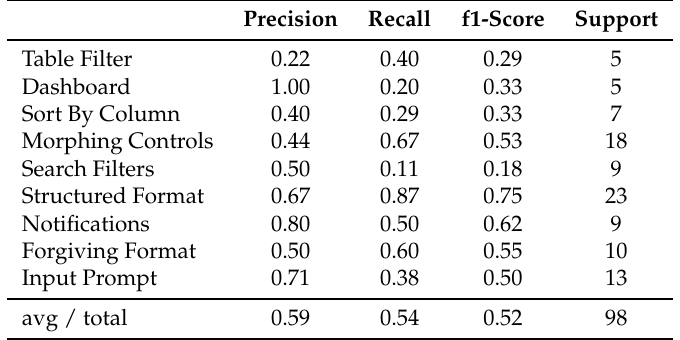
Table 5. Metrics report for the requirements classification by design patterns. Precision Recall f1-Score Support Table Filter 0.22 0.40 0.29 5 Dashboard 1.00 Sort By Column